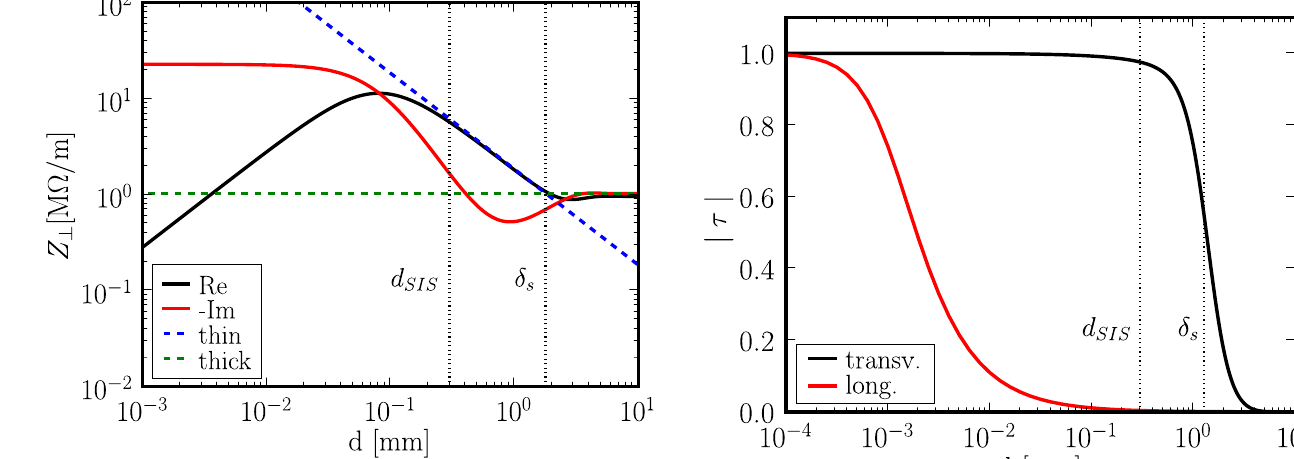
FIG. 1. (Color) The transverse resistive-wall impedance Eq. (27) as a function of the wall thickness for a fixed frequency f (cid:2) and for SIS 100 parameters. Also shown are the thin and 0 : 5 f 0 thick wall approximation results. The SIS 100 wall thickness and the skin depth are indicated.